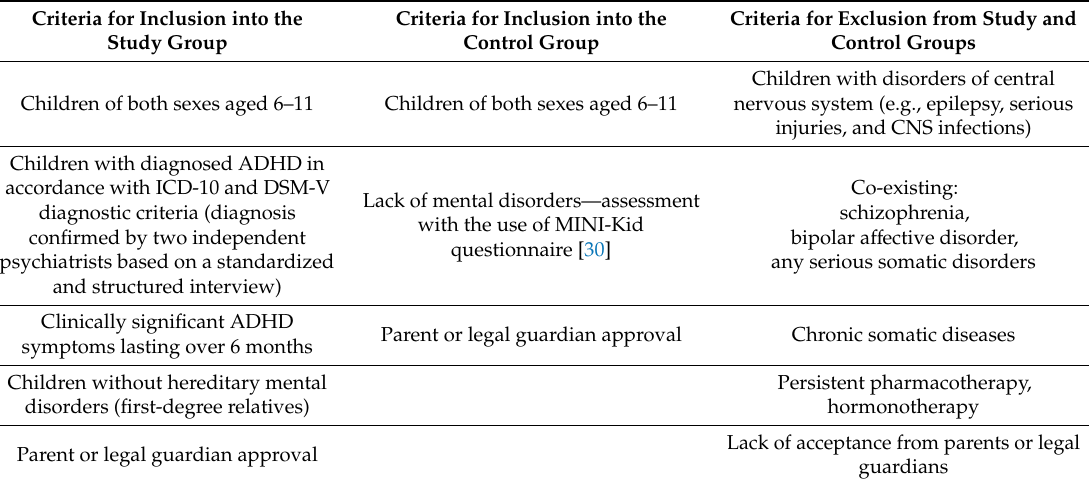
Table 1. Inclusion and exclusion criteria for both